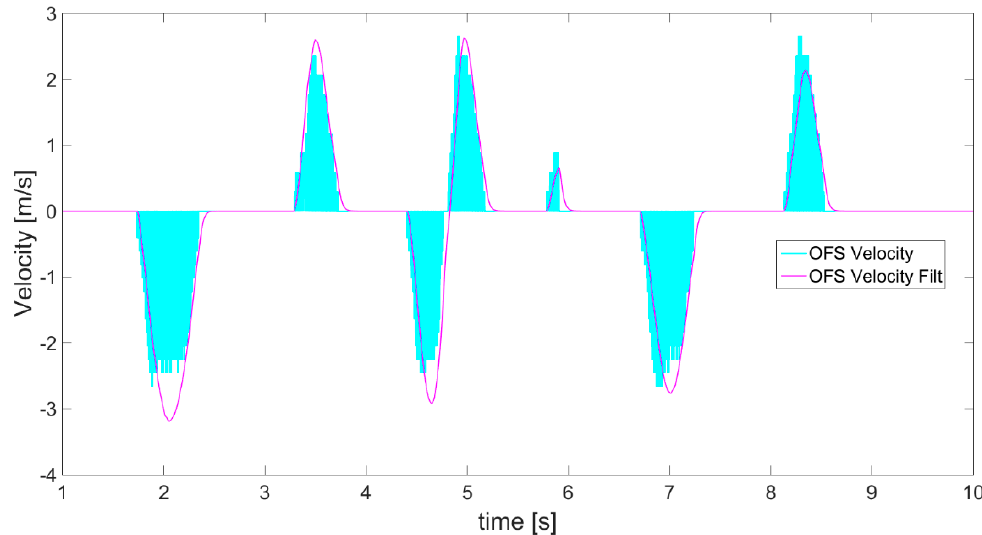
Figure 13. OFS readings of velocity (cyan) and velocity after applying alpha-beta filter (magenta).